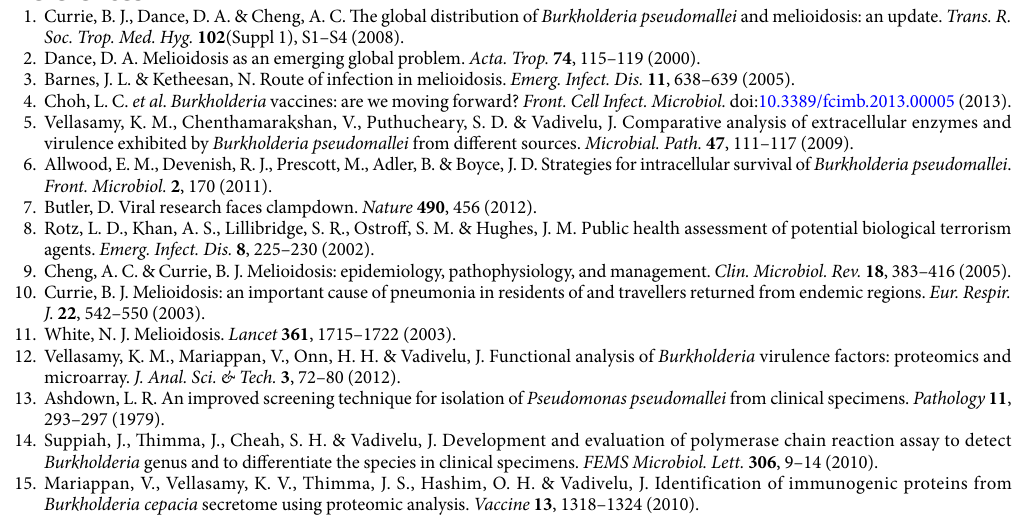
12 Scientific REPORts | 7: 9015 | DOI:10.1038/s41598-017-09373-0